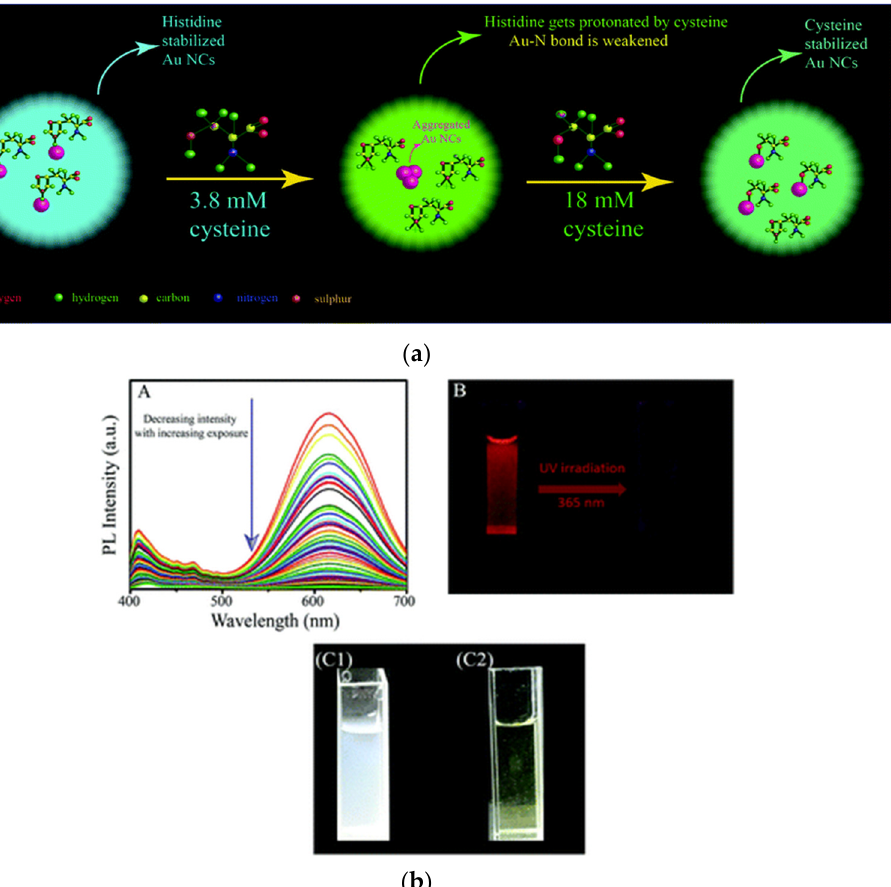
Figure 5. ( a ) Schematic illustration depicting ligand exchange reaction between histidine stabilized Au NCs and cysteine. Reprinted with permission from [84] . Copyright Royal Society of Chemistry 2020 ( b ) Experimental results showing quenching in luminescence of cystine stabilized Cu NCs upon reaction with oxygen in presence of light. Reprinted with permission from [81] . Copyright Royal Society of Chemistry 2019.